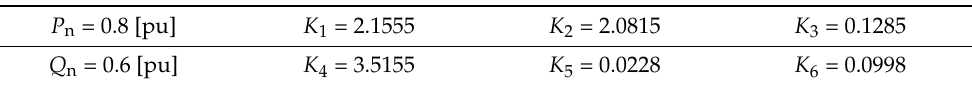
Table 9. Linearization parameters of the H–P model for nominal operating point S n = 15 kVA, cos ϕ n = 0.8.